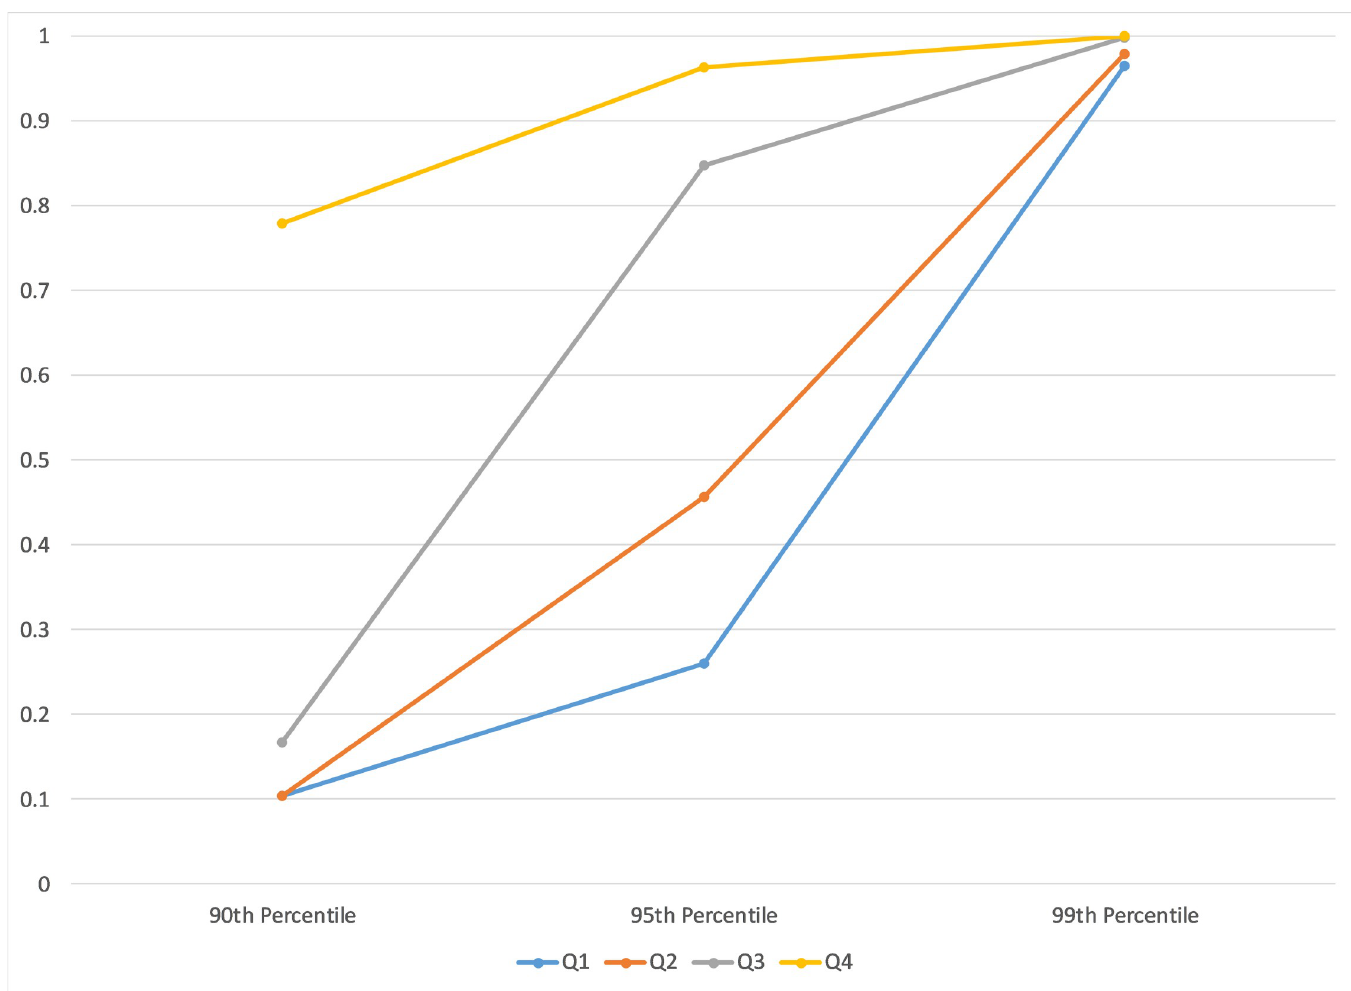
Fig 5. Probability establishment is design integrated for 90 th -99 th percentile by arts-design